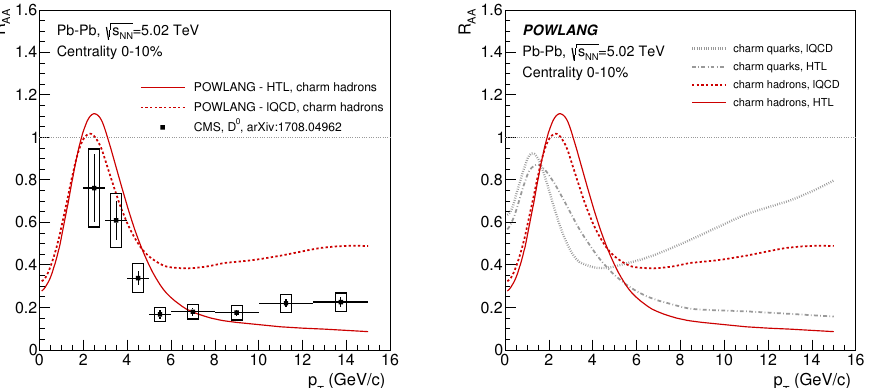
Figure 13 . POWLANG results with weak-coupling and l-QCD transport coe(cid:14)cients for the nuclear modi(cid:12)cation factor of charm hadron (left panel) and quark (right panel) spectra in central Pb-Pb p collisions at s NN = 5 : 02 TeV. Transport-model predictions are compared to CMS data for D 0 - mesons